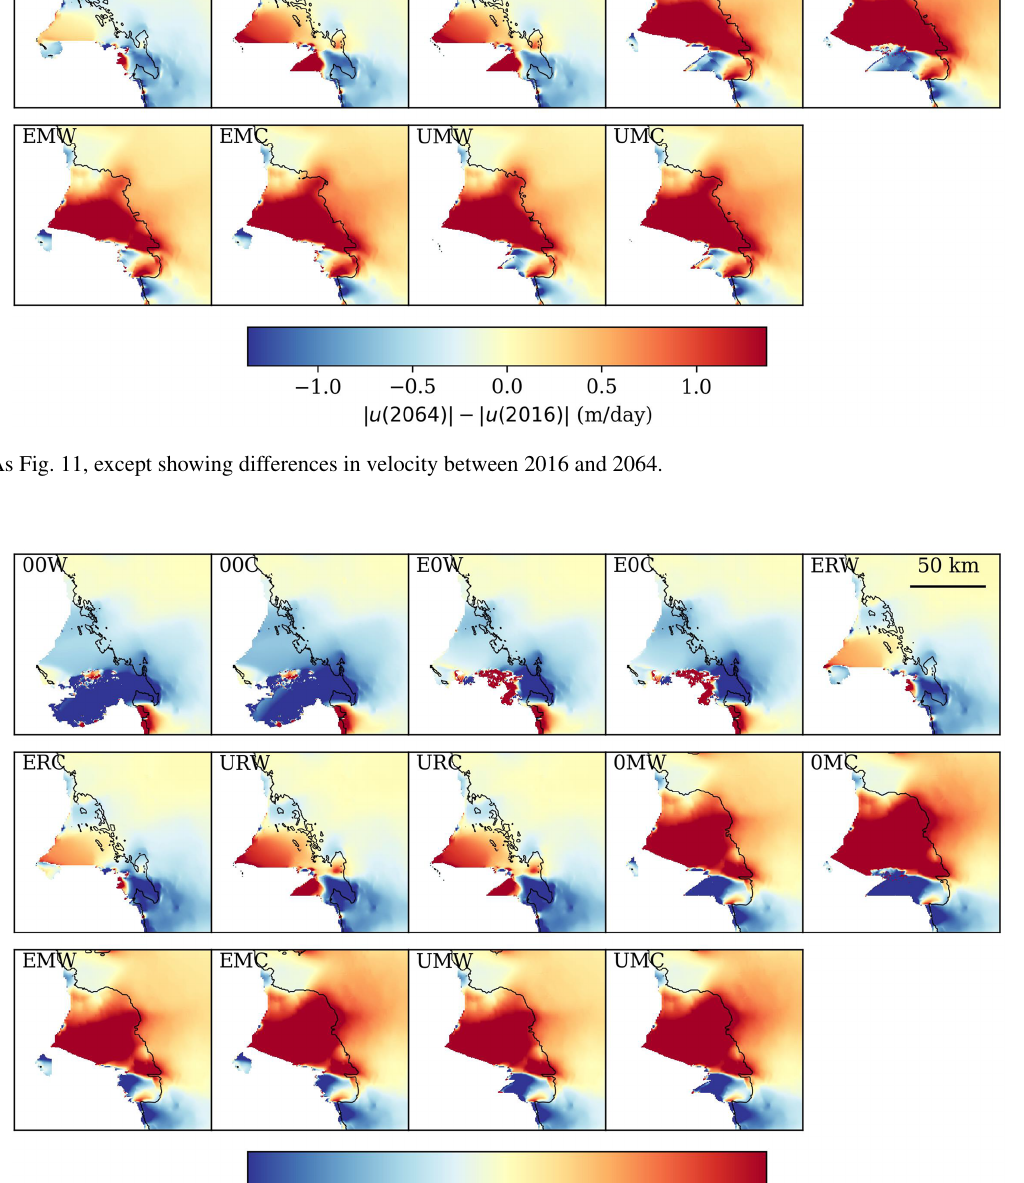
https://doi.org/10.5194/tc-16-2545-2022 The Cryosphere, 16, 2545–2564,